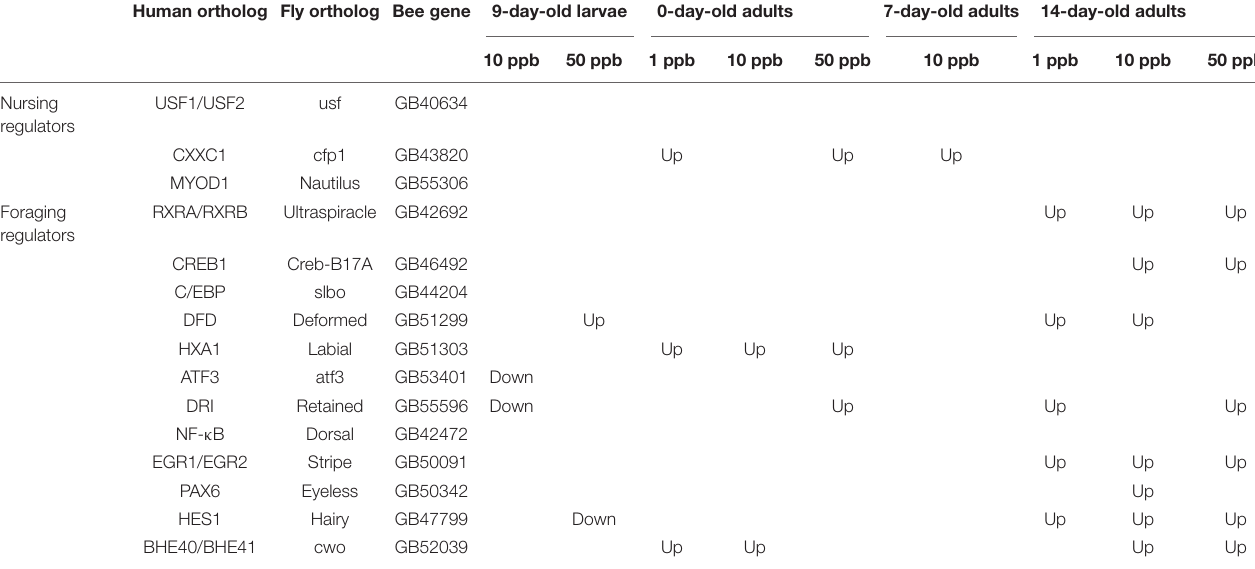
TABLE 3 | Differentially expressed genes related to transcriptional regulators of honey bee behavioral state at different developmental ages after imidacloprid treatment. Human ortholog Fly ortholog Bee gene 9-day-old